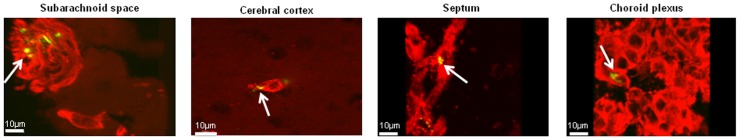

S.
pneumoniae adheres to the brain vascular endothelium.Visualization of S. pneumoniae (green) adhering to the brain vascular endothelium (red) using confocal microscopy. The scale of each image is shown by the white scale bar. White arrows points to completely overlapping staining of the bacteria and the lectin resulting in a yellow color, strongly suggesting a co-localization of S. pneumoniae with endothelial cells. For each time point of infection, brains from 3 mice were analyzed, and of each mouse 3 brain sections were used for the confocal detection. The images at the later stages of infection were used because more bacteria were detected at those time points and thus these provide a clear picture of the bacteria anchored to the vasculature. Images of all time points after infection are shown in Figure S2.